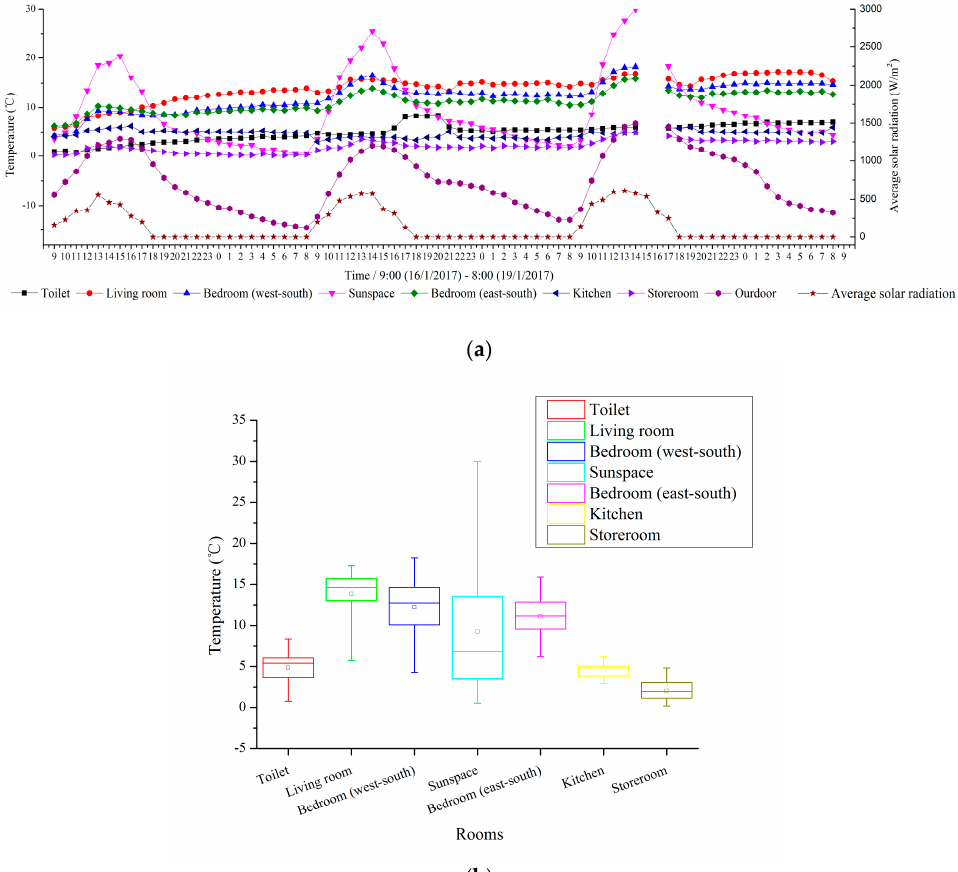
Figure 6. Average air temperature of each room (active solar heating condition); ( a ) Hourly average temperature variation; ( b ) Hourly average temperature histogram.